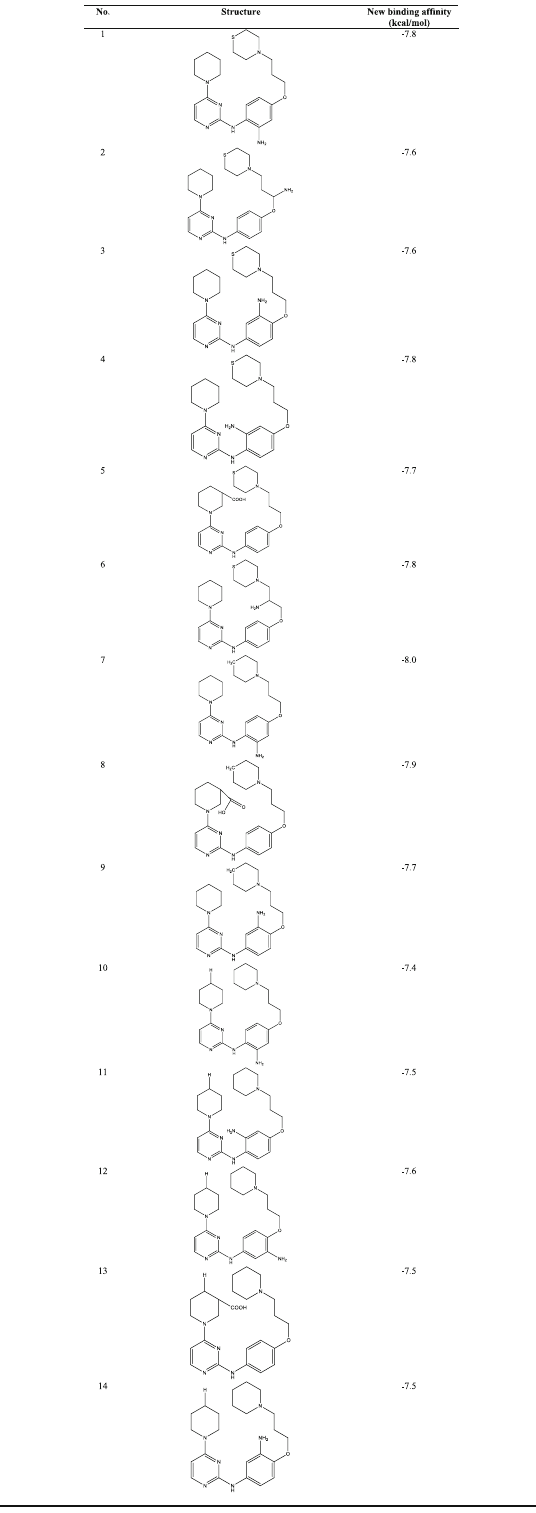
Table 3 Newly designed 2-anilinopyrimidine compounds against MBA-MB-468 cell